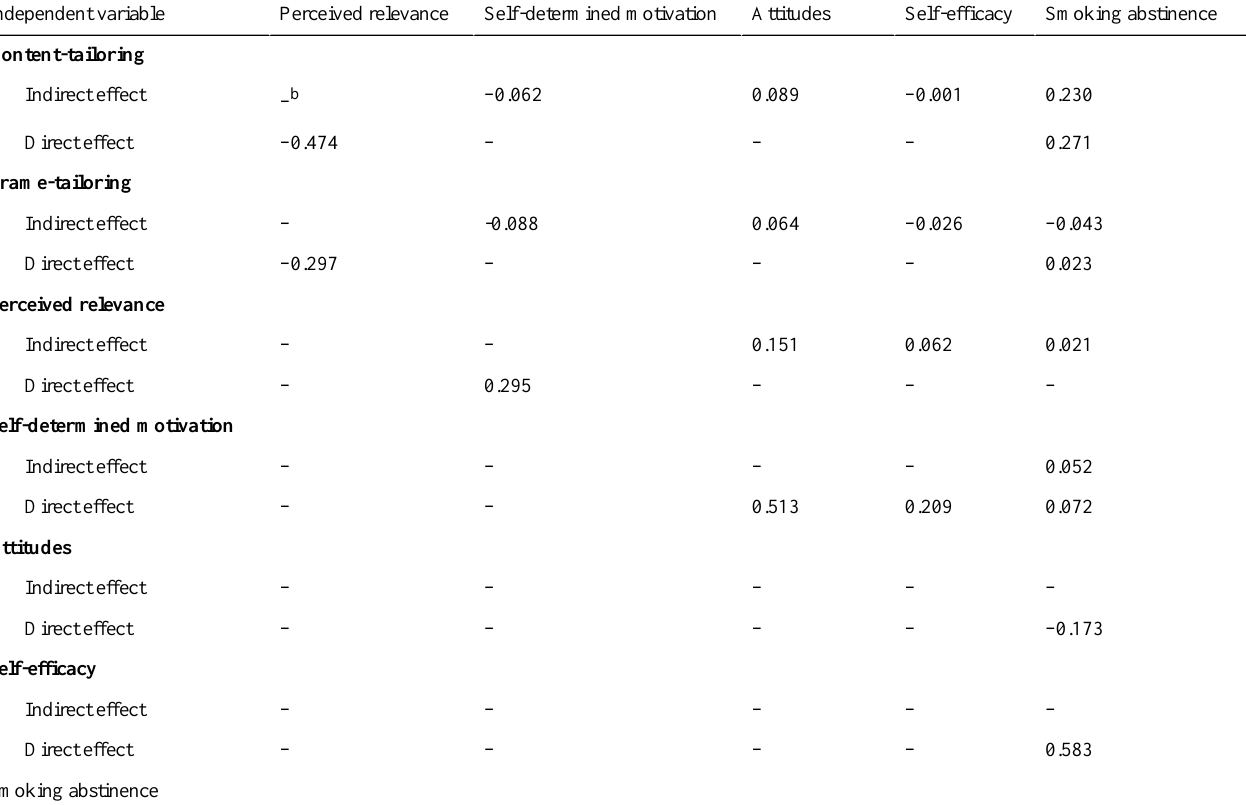
Table 4. Standardized indirect and direct effects of the trimmed model a